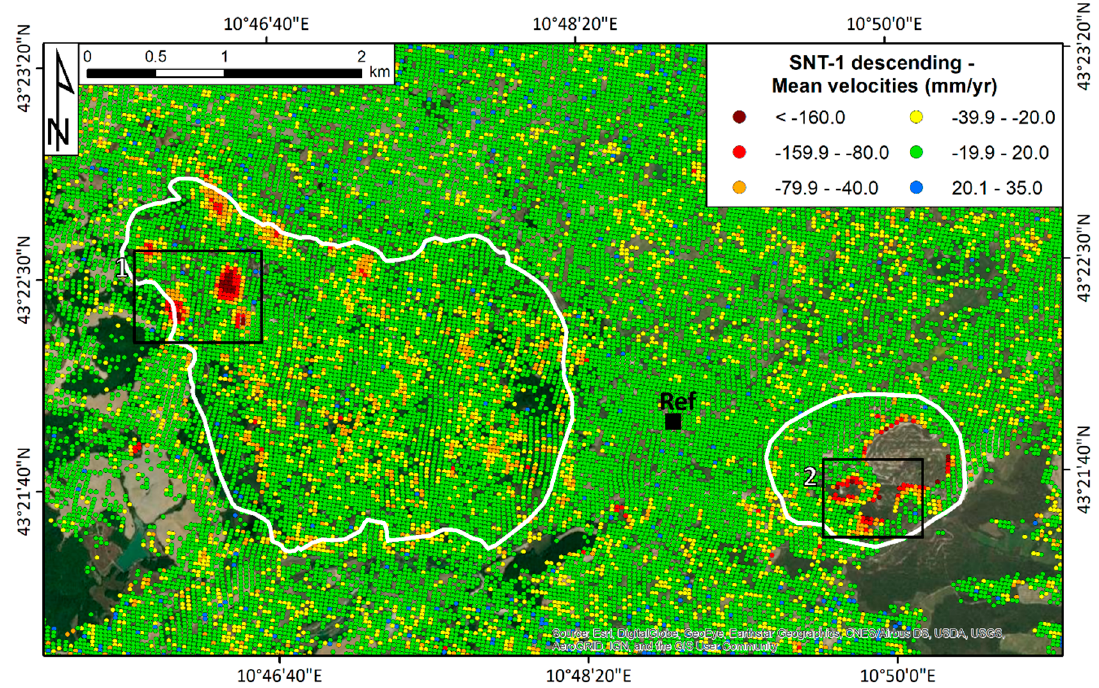
Figure 5. Sentinel-1-derived deformation map for the area of interest. The black dot is the reference point, located in the stable area of the Saline di Volterra village. The white contours are the two target areas. The two black square represent the two areas with the highest deformation rates (1, Buriano-Casanova, part of the Buriano deformation area; 2, Poppiano-Volterra, part of the Poppiano deformation area) which are the focus of the next two sections. The background image is an ESRI World Image.